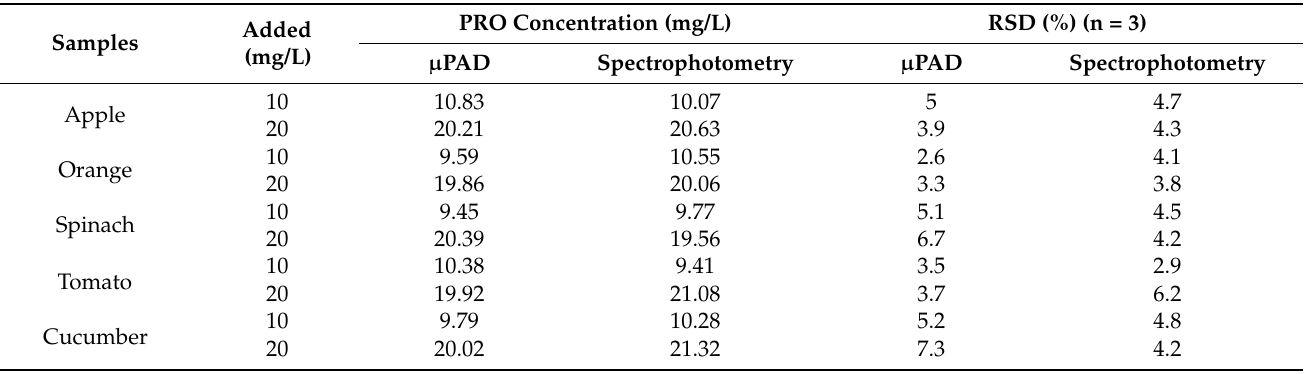
The detection of PRO in five fruit and vegetable samples by pSBMA- µ PAD and UV–visible